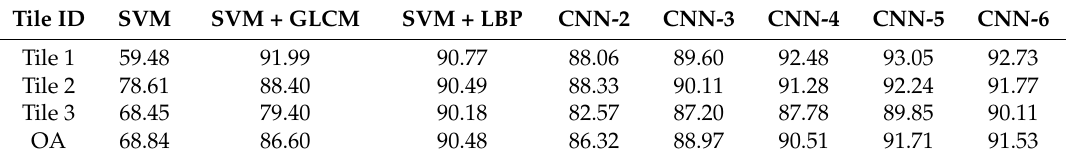
Table 4. Comparison of classification accuracies of Support Vector Machines (SVM), SVM + Grey